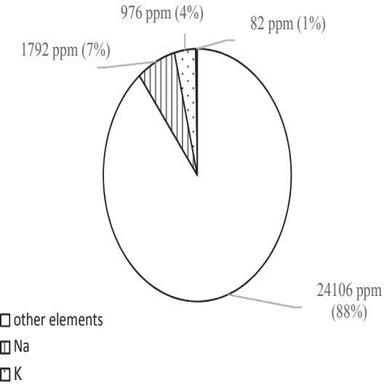
ICP plasma spectroscopy data concentrations of alkali metals in Limestone sample.